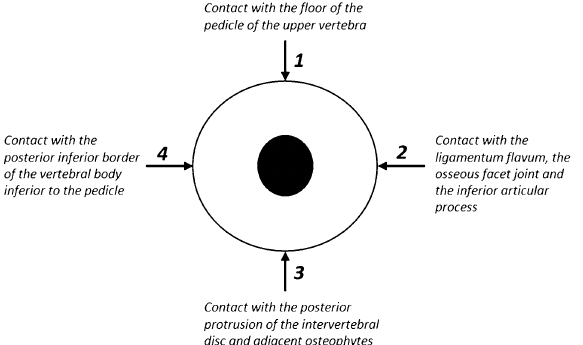
Figure 1. Illustration of the lumbar foramen and explanation of positional